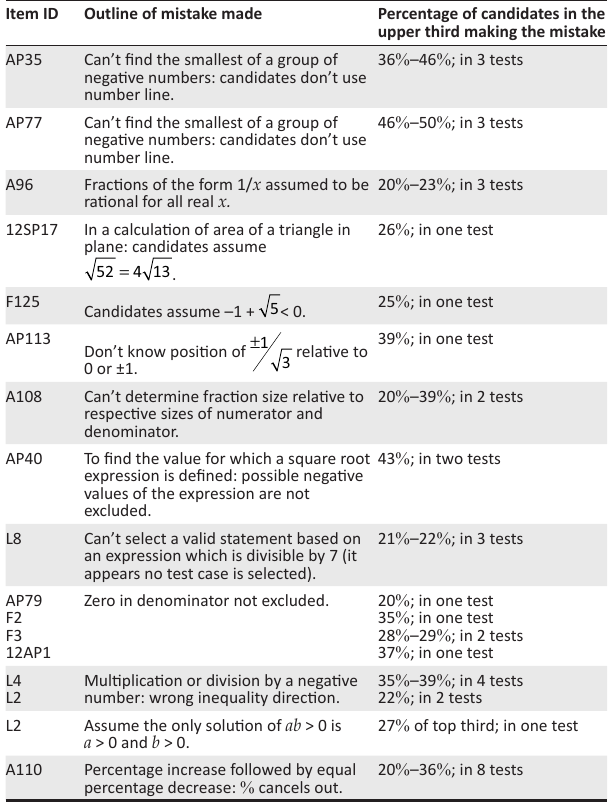
TABLE 8: Number sense. Item ID Outline of mistake made Percentage of candidates in the